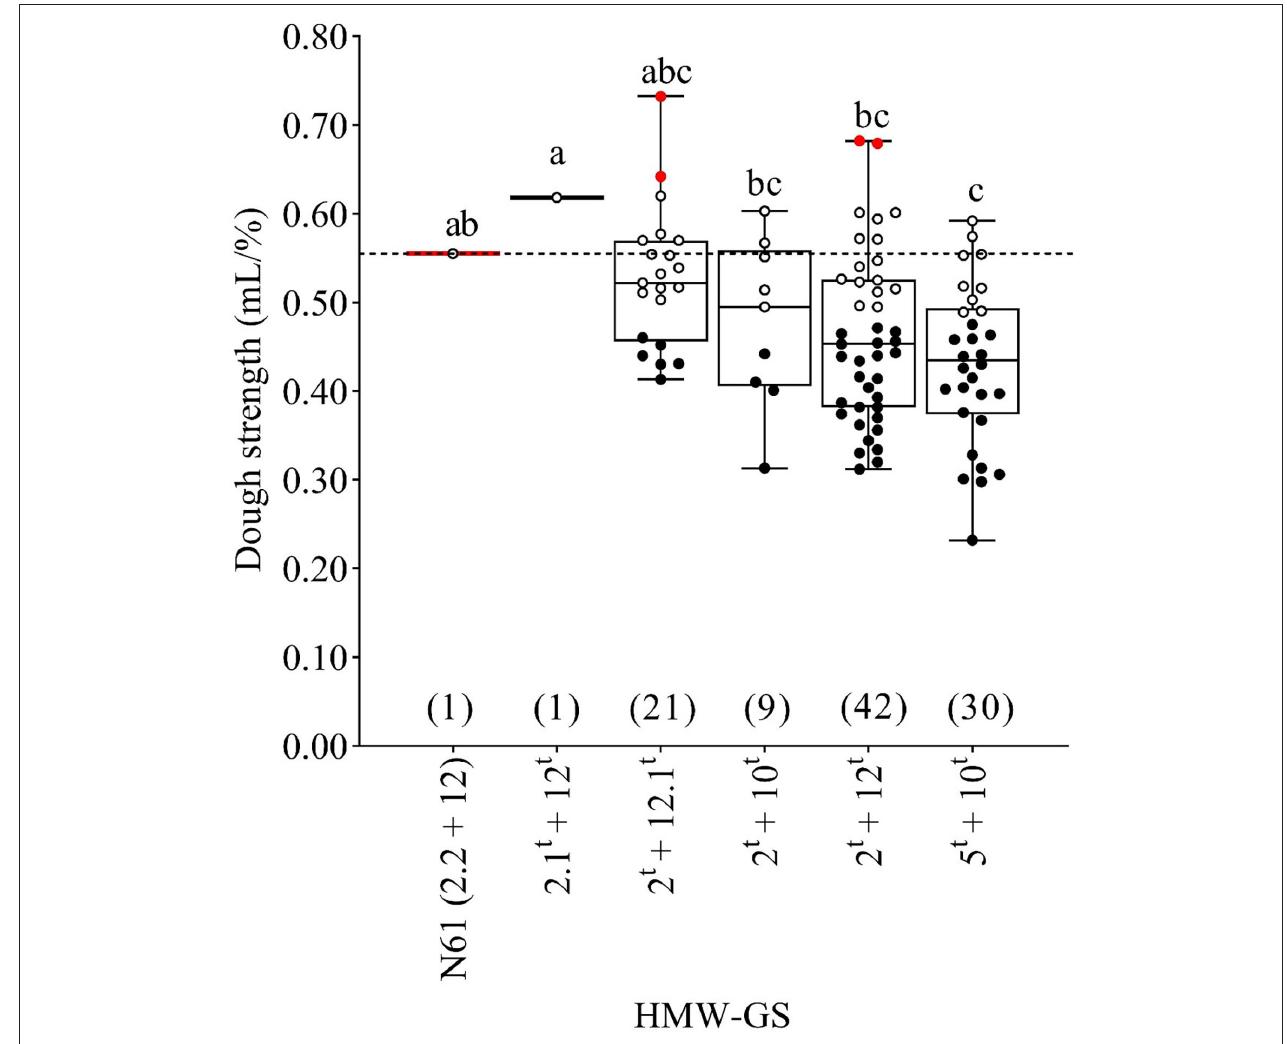
FIGURE 4 | Boxplot for the dough strength (mL/%) as affected by the HMW-GS pairs derived from Ae. tauschii and the recurrent parent N61. Similar lower case letters indicate that the means for HMW-GS pairs are not significantly different according to Duncan’s Multiple Range Test at P < 0.05. A horizontal dashed line compares the N61 value with the values of other MSD lines. Red, white, and black dots indicate the MSD lines that were significantly higher, comparable, or lower than N61, respectively, according to the least significant difference (0.05). Numbers in parentheses refer to the number of MSD lines having each HMW-GS pair.